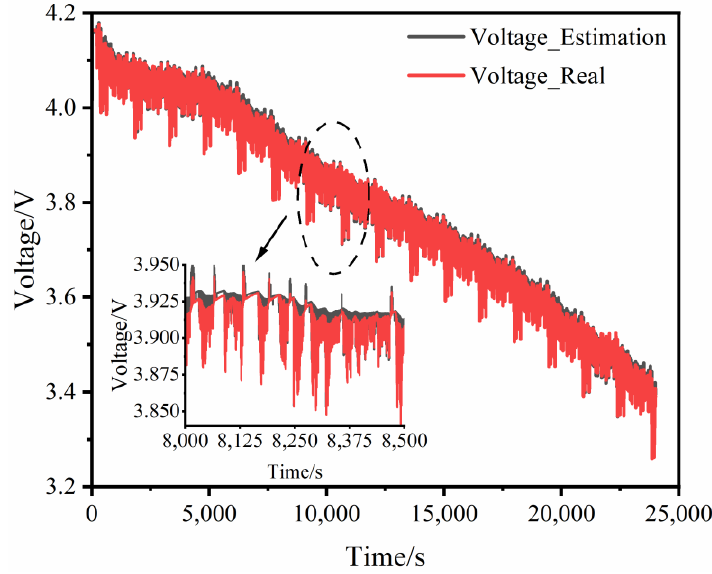
Figure 6. Battery terminal voltage diagram.